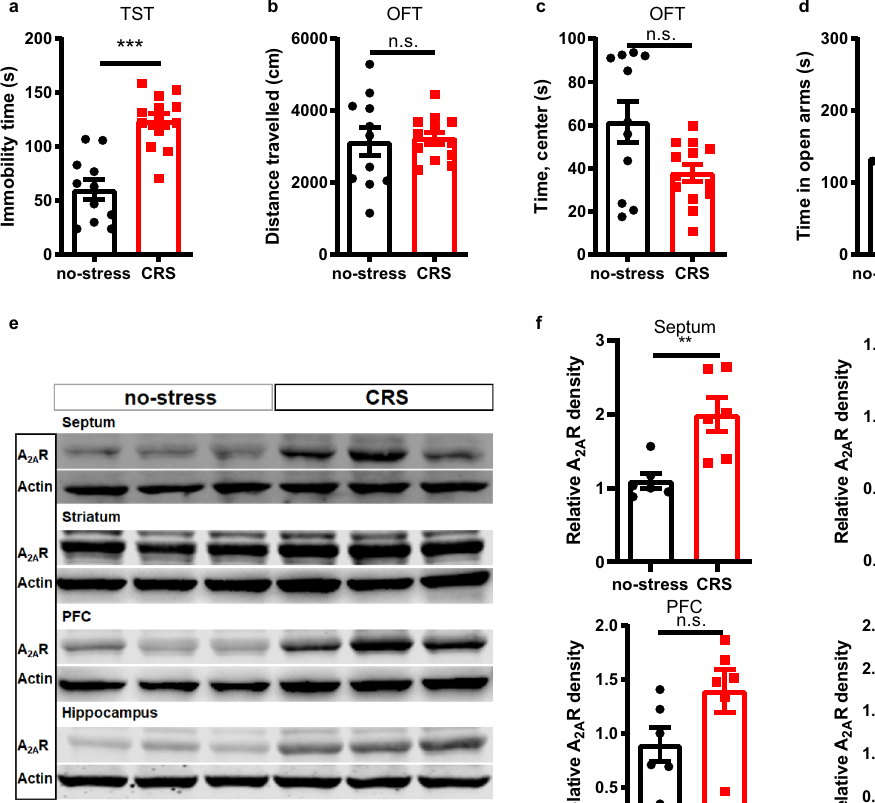
Fig. 6 | A 2A R are selectively upregulated in the lateral septum (LS) of mice subject to chronic restraint stress (CRS). a – d Compared with control mice, CRS mice showed an increase in immobility time in a tail suspension test (TST) ( n =11 and 13 mice per group for no-stress and CRS, respectively, Unpaired t test, p =0.00001, t(22)=5.674) ( a ), without changes in the total distance traveled in an open fi eld test (OFT) ( n =11 and 13 mice per group for no-stress and CRS, respec- tively, Unpaired ttest, p =0.8169, t(22)=0.2343)( b ).CRS micespent similartime in the center area of the OFT ( n =11 and 13 mice per group for no-stress and CRS, respectively, Mann-Whitney test, p =0.0821, U=41) ( c ) and in the open arms of an elevated O-maze test ( n =11 and 13 mice per group for no-stress and CRS,